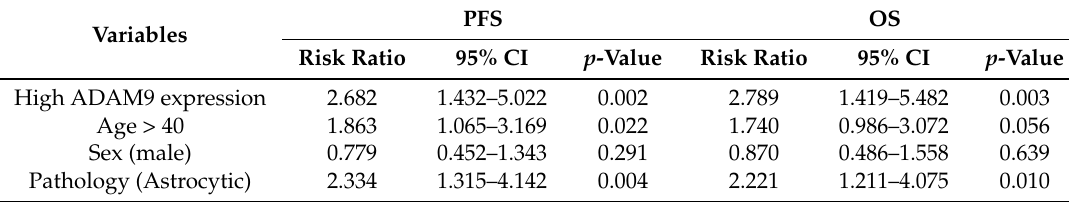
* Results of Cox regression